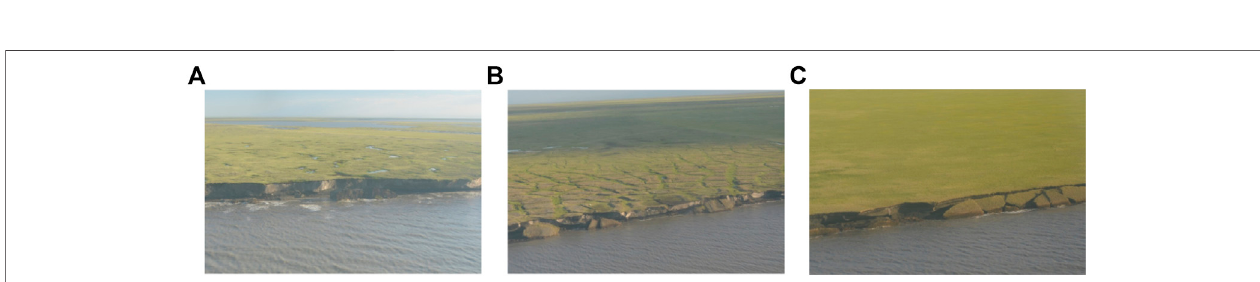
FIGURE1| CoringactivitieswereconductednearDrewPoint,AKinApril2018usinga (A) SIPREcoringsystemtocollectnear-surface(top4 – 6 m)coresanda (B) Geoact coring system to retrieve cores at depth.